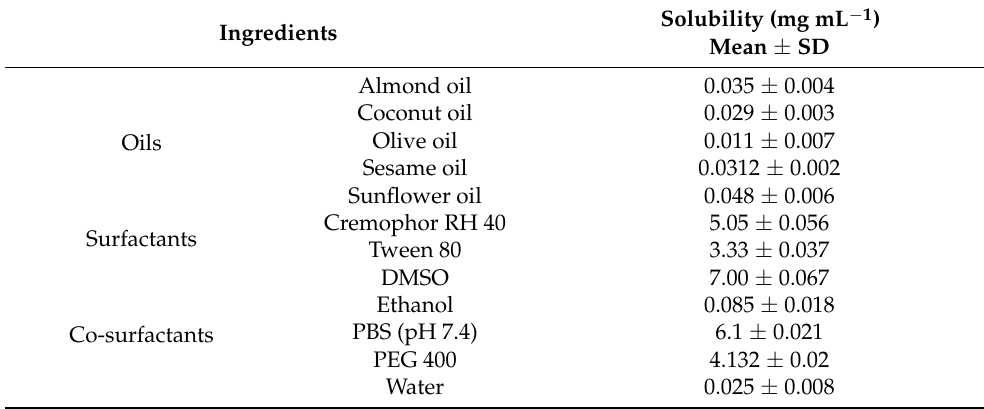
Table 1. Lornoxicam solubility in selected oils, surfactants, and